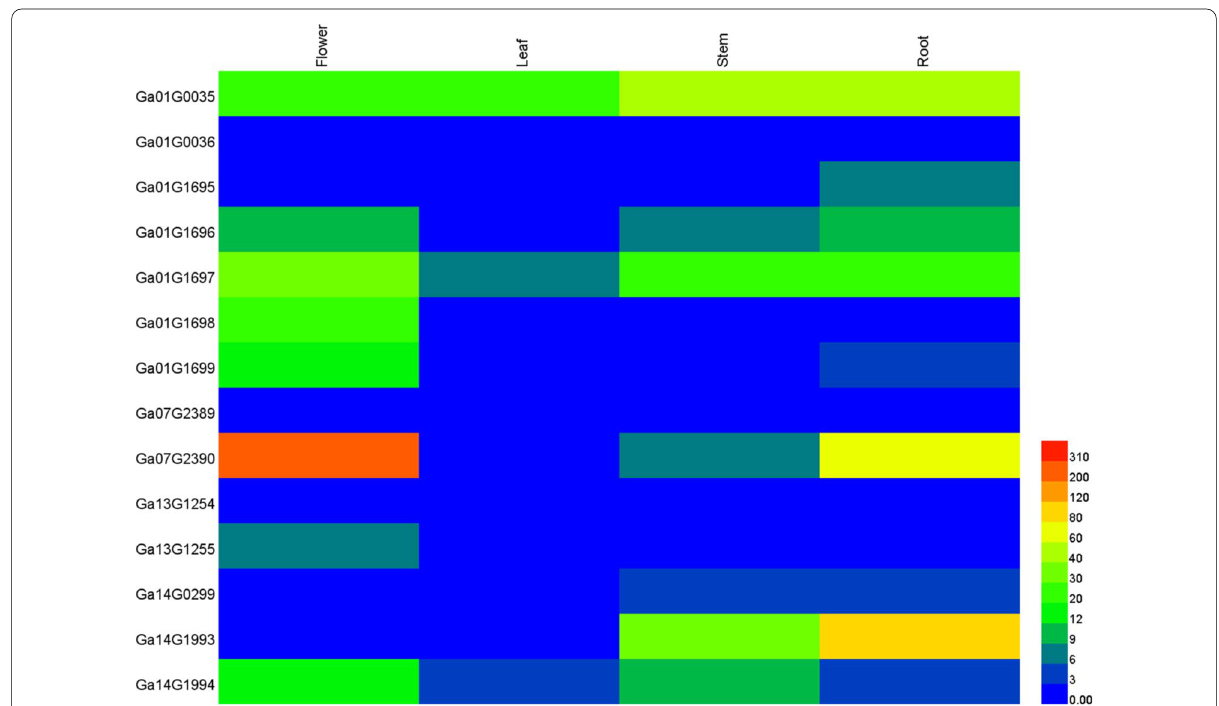
Fig. 5 Heatmap of TPM value for candidate genes in Asian cotton standard line